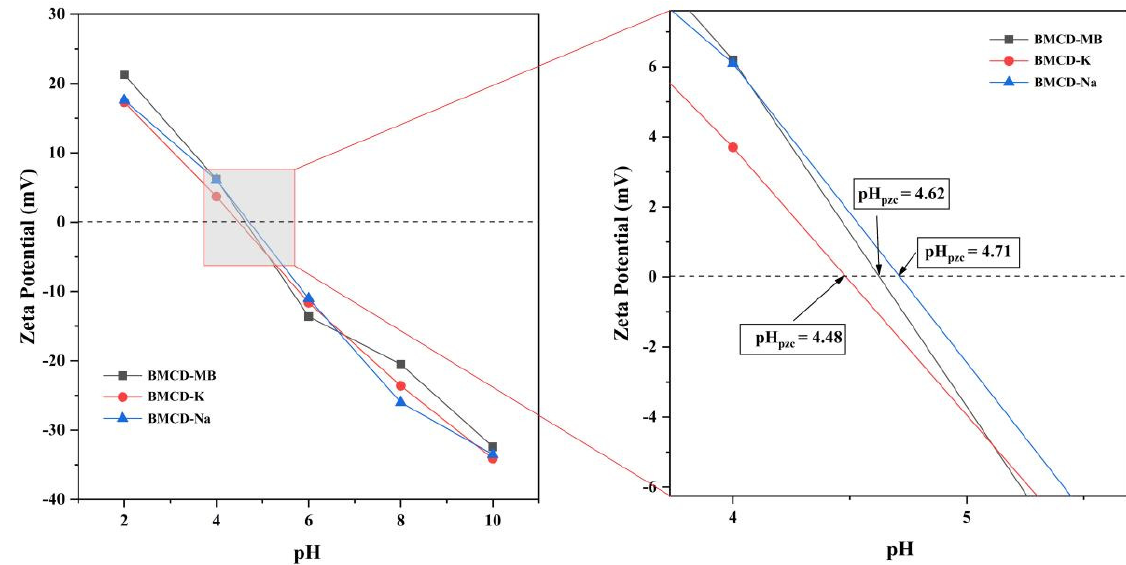
Figure 5. Zeta potential tests of BMCD-K, BMCD-Na, and BMCD-MB.